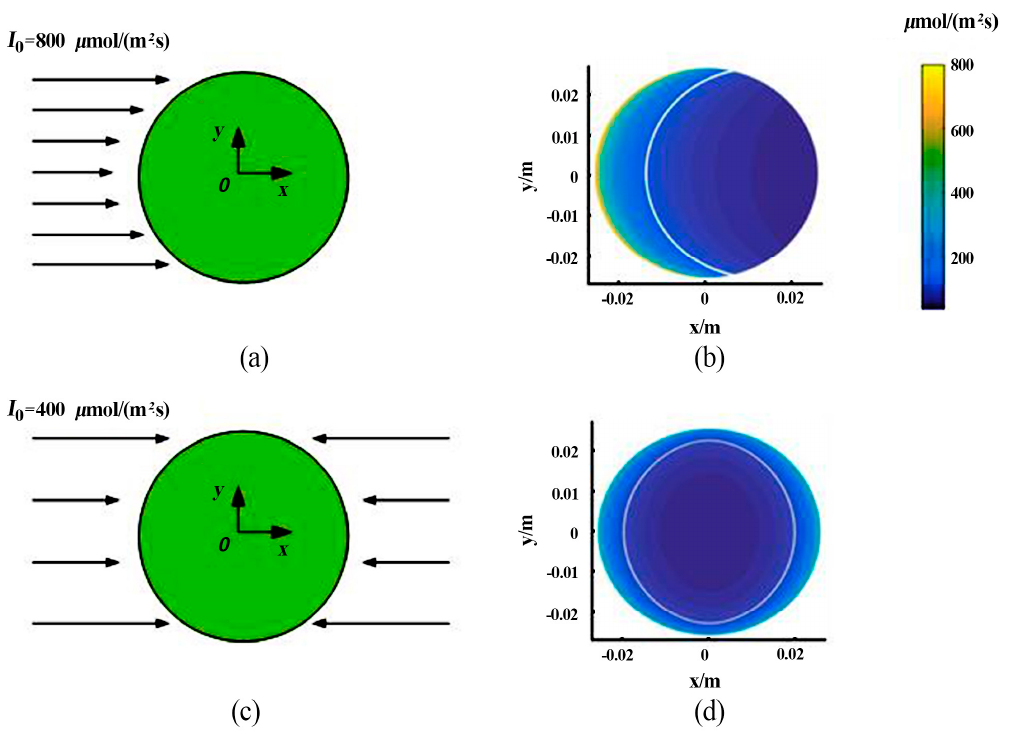
Figure 4. Schematic diagram of illumination. ( a ) Single-sided illumination; ( b ) light field on the PBR cross section under single-sided illumination; ( c ) double-sided illumination; ( d ) light field on the PBR cross section under double-sided illumination.